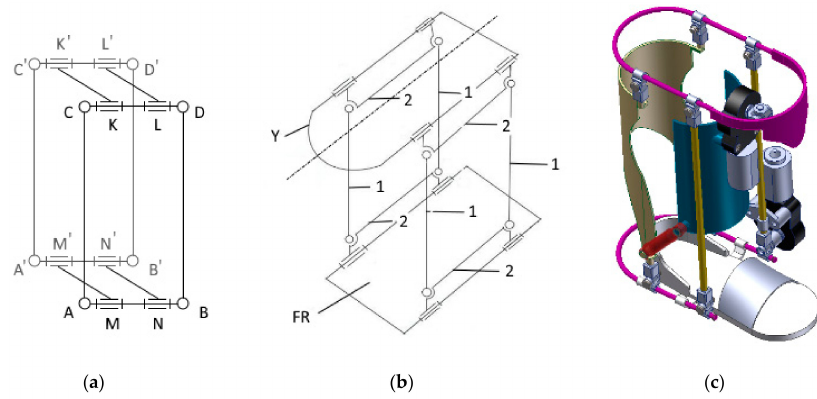
Figure 2. Design stages of the lower limb exerciser: ( a ) kinematic chain ( b ) mechanism, where FR is the foot resting plate, Y is the yoke, with 1 are designated the vertical linkages (0.330 m) and with 2—the horizontal linkages (0.143 m); dotted line represents the rotational axis ( c ) CAD model of the exerciser.